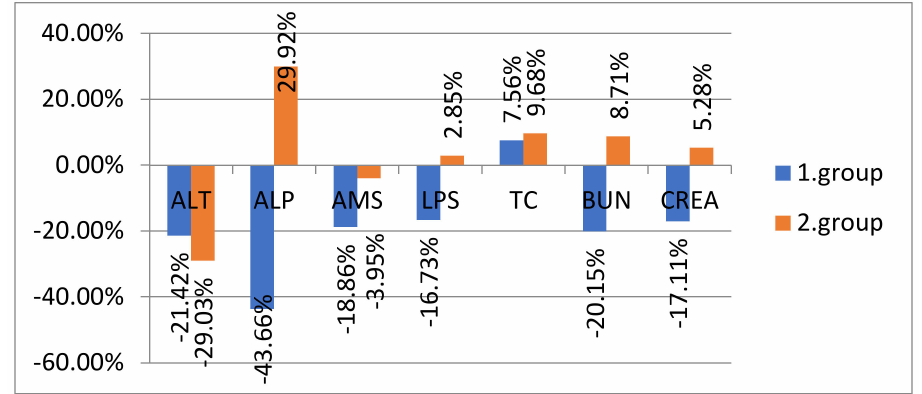
Figure 2. Percentage increase/decrease in averages of biochemical indicators in both groups after therapy. Legend: ALT, alanine aminotransferase; ALP, alkaline phosphatase; AMS, amylase; LPS, lipase; TC, total cholesterol; BUN, urea; CREA, creatinine; “1. group” is the group of dogs treated with acupuncture, phytotherapy and nutrition; “2. group” is the group of dogs treated with conventional Western medicine drug